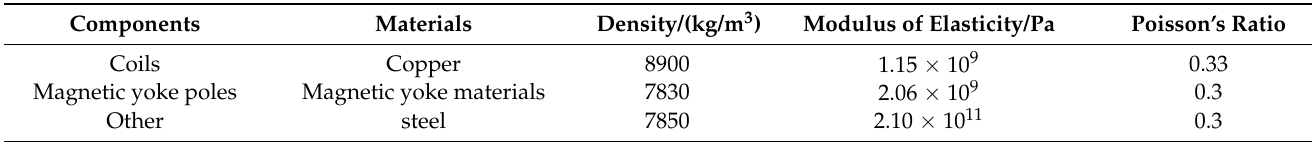
Table 2. Material properties of the rotor system